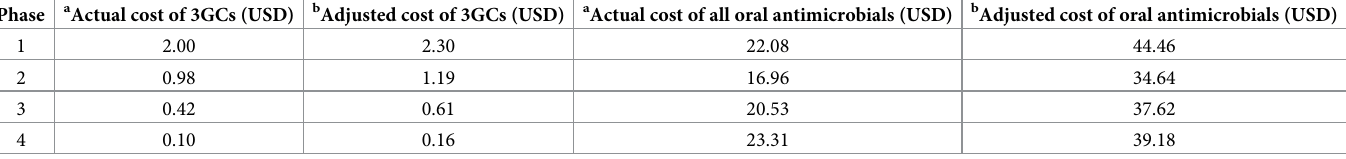
Table 2. Average purchase costs of 3GCs and all oral antimicrobials per 100 patient-days from Phases